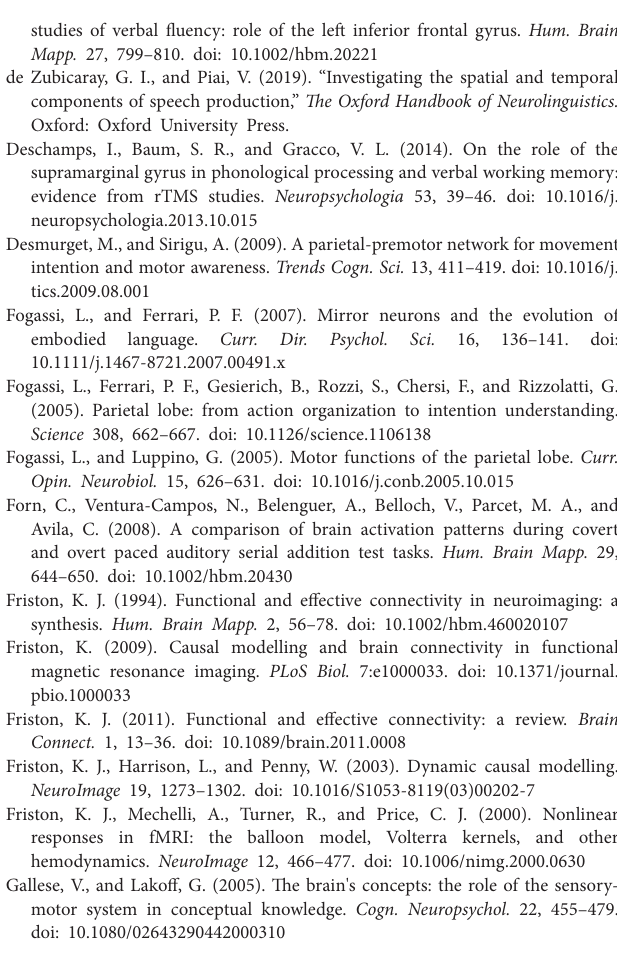
Supplementary Figure S1 | Visual stimuli in this experiment. Supplementary Figure S2 | Predefined DCM models across PMC, IFG, and IPL. Model 1, 2, 4, 8, 16, 32 were the basic models with single task effect. The additional 57 models are the combinations of these six models. “+” means the combination of two models. Model 3 = 1 + 2, Model 5 = 1 + 4, Model 6 = 2 + 4, Model 7 = 1 + 2 + 4,